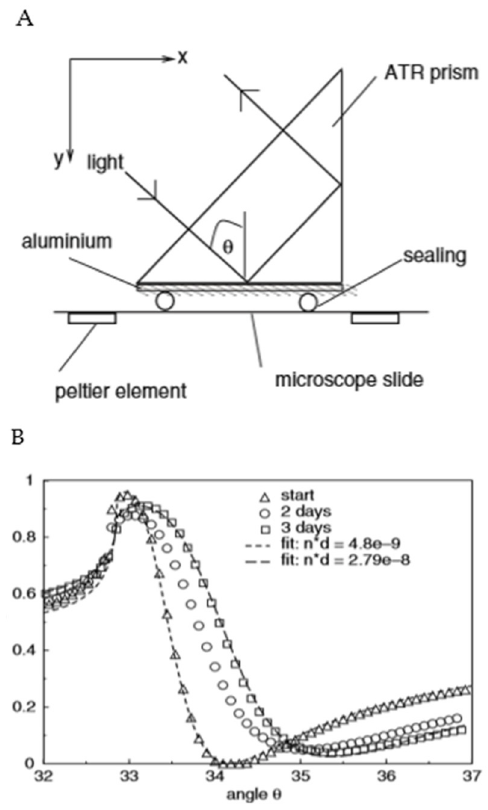
Figure 5. ( A ) Optical setup for monitoring biofilm formation through Al SPR. ( B ) SPR shifts of Al film Figure 5. ( a ) Optical setup for monitoring biofilm formation through Al SPR. ( b ) SPR shifts of Al film in contact with a biofilm. (Adapted from Leitz et al. in contact with a biofilm. (Adapted from Leitz et al.[206]).